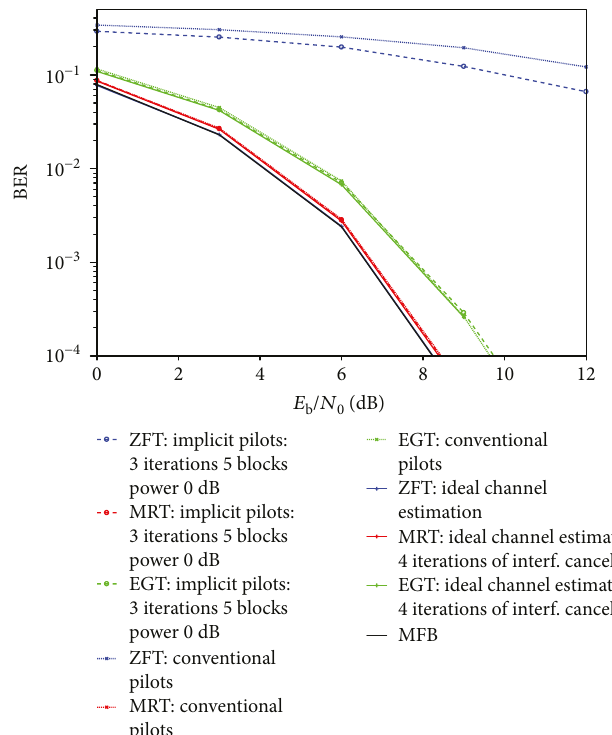
Figure 11: BER results with 32 × 2 using implicit pilots with 5 data blocks, 3 iterations, and a pilot power of 0 dB versus conventional